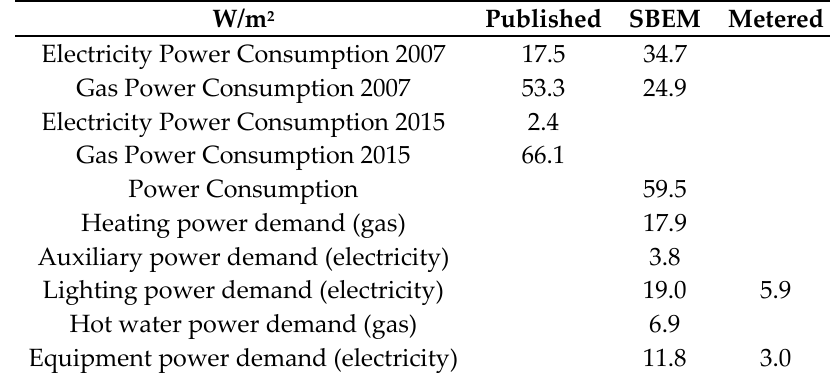
Table 1. Energy metric published by TRFT, predicted for two departments by SBEM and as monitored.